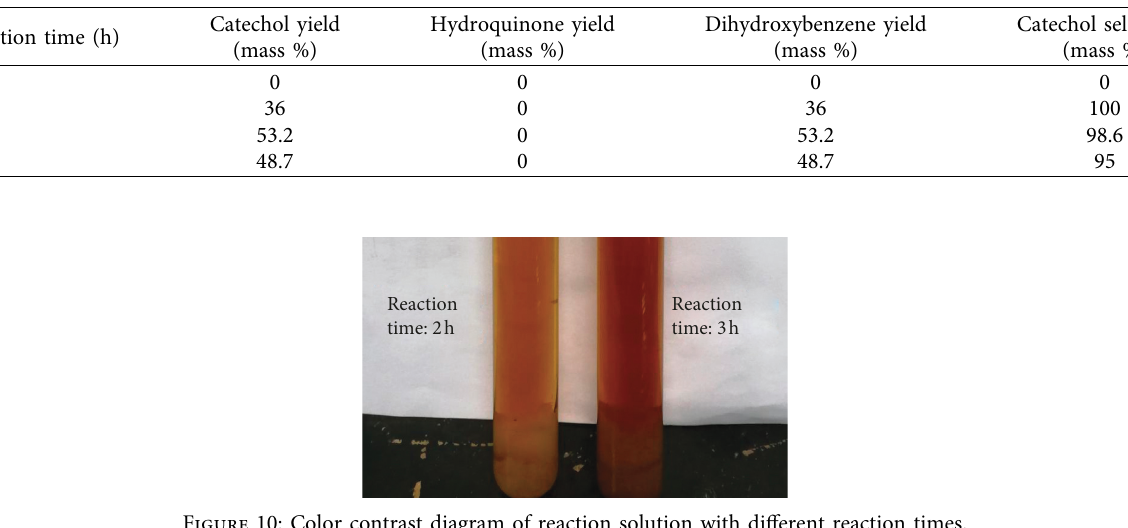
Table 4: Effect of reaction time on the phenol hydroxylation.